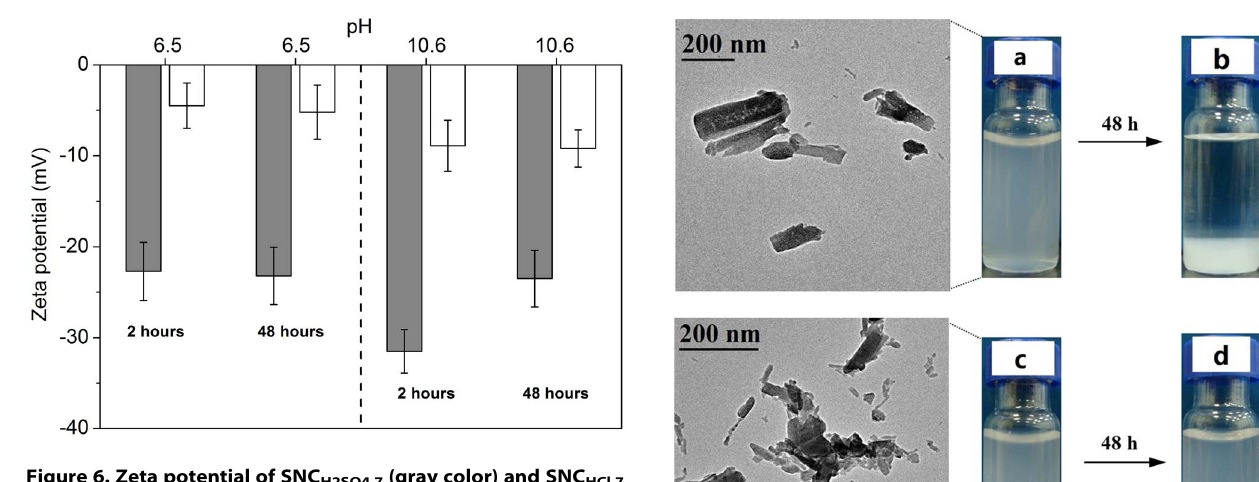
Figure 6. Zeta potential of SNC H2SO4,7 (gray color) and SNC HCl,7 (white color) suspensions at pH 6.5 and 10.6 placed for 2 h and 48 h, respectively. Data are represented as the mean 6 standard deviation (n=3).